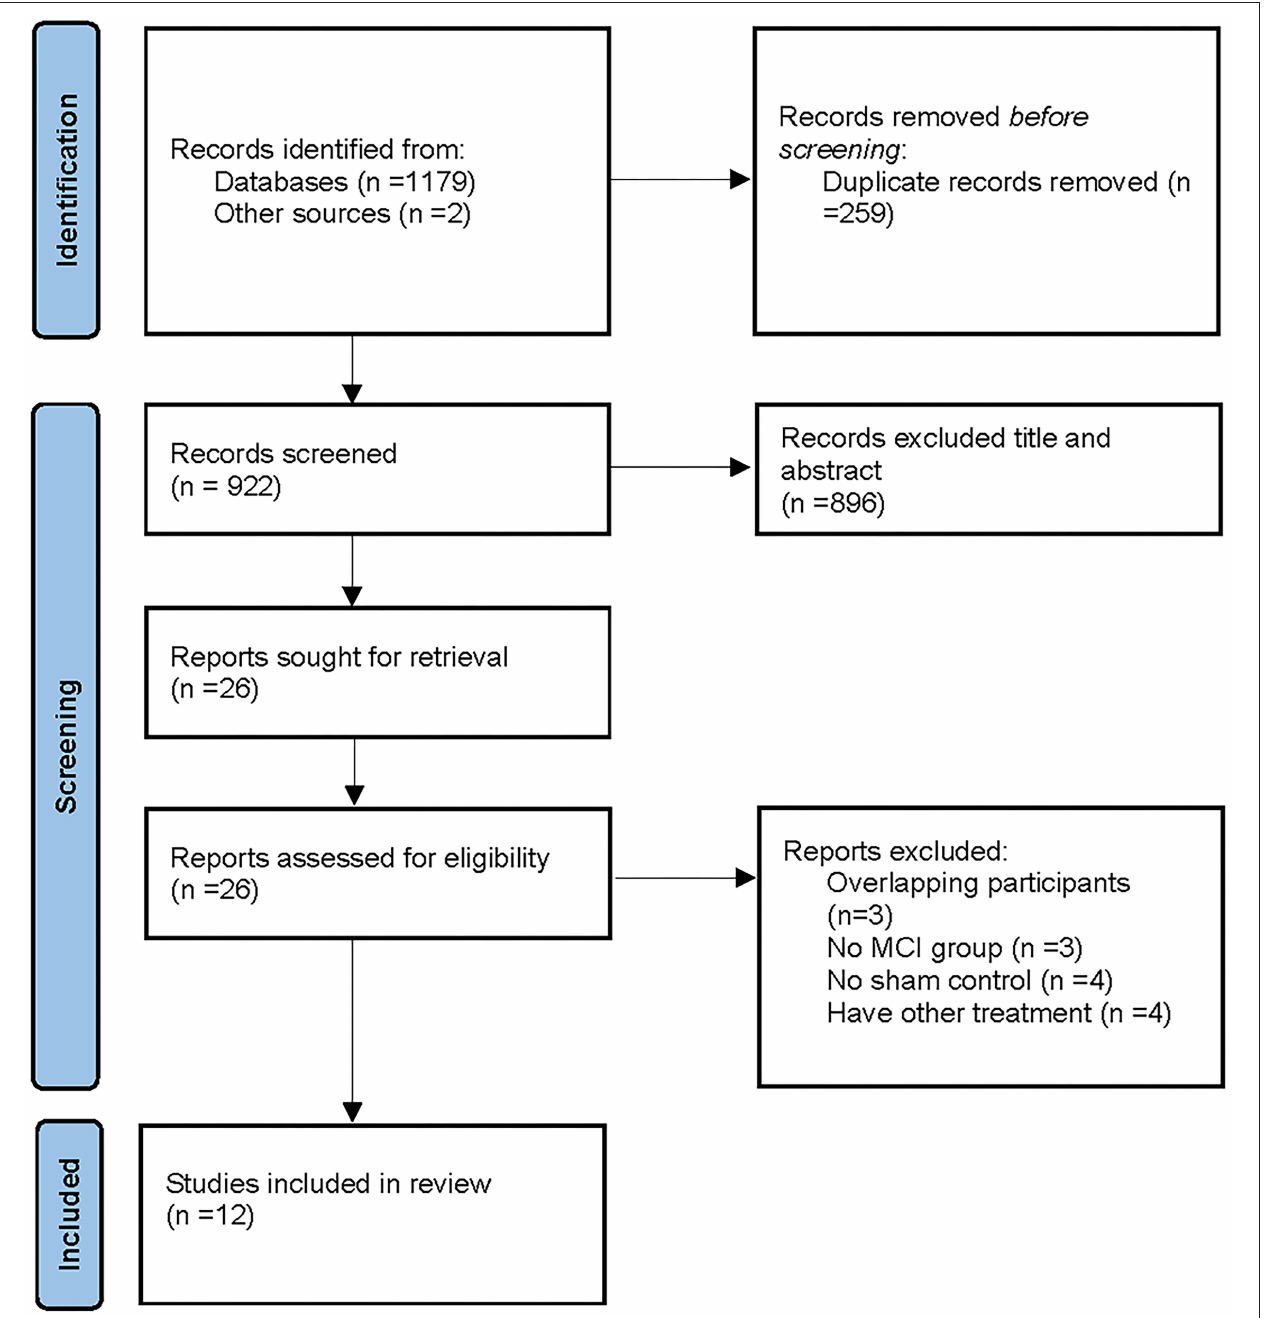
FIGURE 1 | A flow diagram showing the search and inclusion criteria for studies [Based on PRISMA statement (www.prisma-statement.org)]. Other sources from Chou et al. (2020).